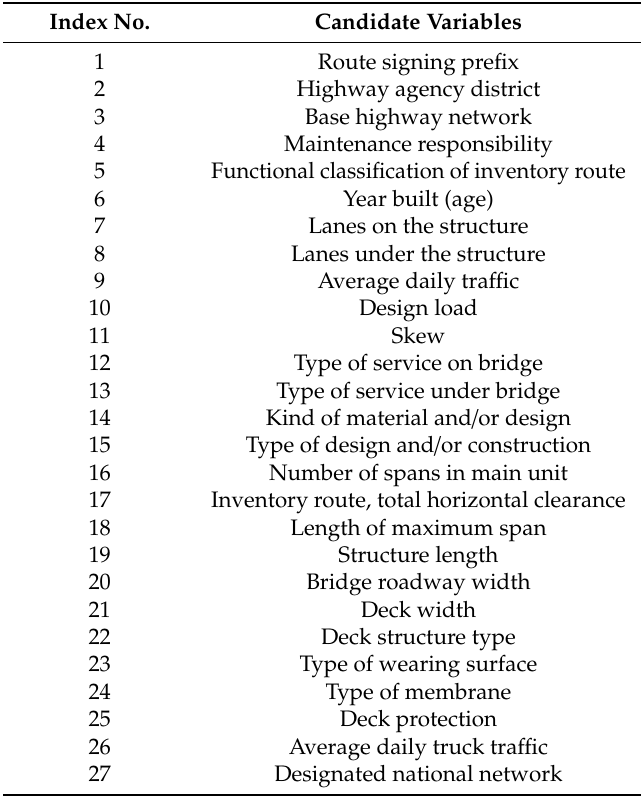
Table 1. List of candidate